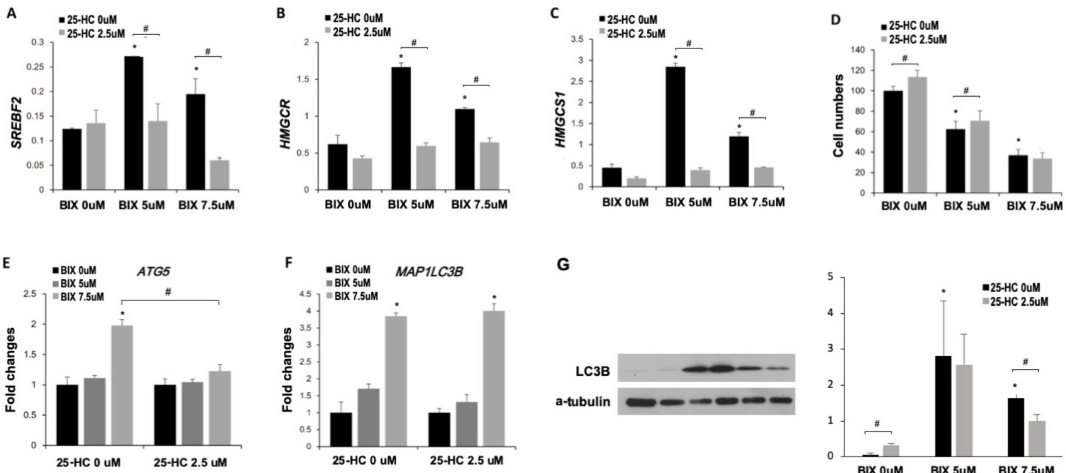
Figure 5. Involvement of cholesterol biosynthesis pathway in BIX-induced cell death. ( A – C ) Expression of SREBF2 ( A ), HMGCR ( B ), and HMGCS1 ( C ) was analyzed in BIX- and 25-hydroxycholesterol (25-HC)-treated H1299 cells. ( D ) MTT assay was conducted in lysates of H1299 with BIX and 25-HC treatment, based on 0 µ M of BIX and 25-HC as 100%. ( E , F ) Expression of the autophagy-related genes ATG5 ( E ) and MAP1LC3B ( F ) was analyzed in BIX- and 25-HC-treated H1299 cells. Data were normalized by the value of 0 µ M BIX in each 25-HC treatment. ( G ) LC3B protein levels were analyzed by Western blotting after BIX and 25-HC treatment for 48 h in H1299 cells. α -Tubulin levels are shown as loading control. Relative intensities of LC3B-II bands against a-tublin were quantified and presented in the right panel. * p < 0.05 versus 0 µ M BIX treatment. # p < 0.05 versus 2.5 µ M 25-HC